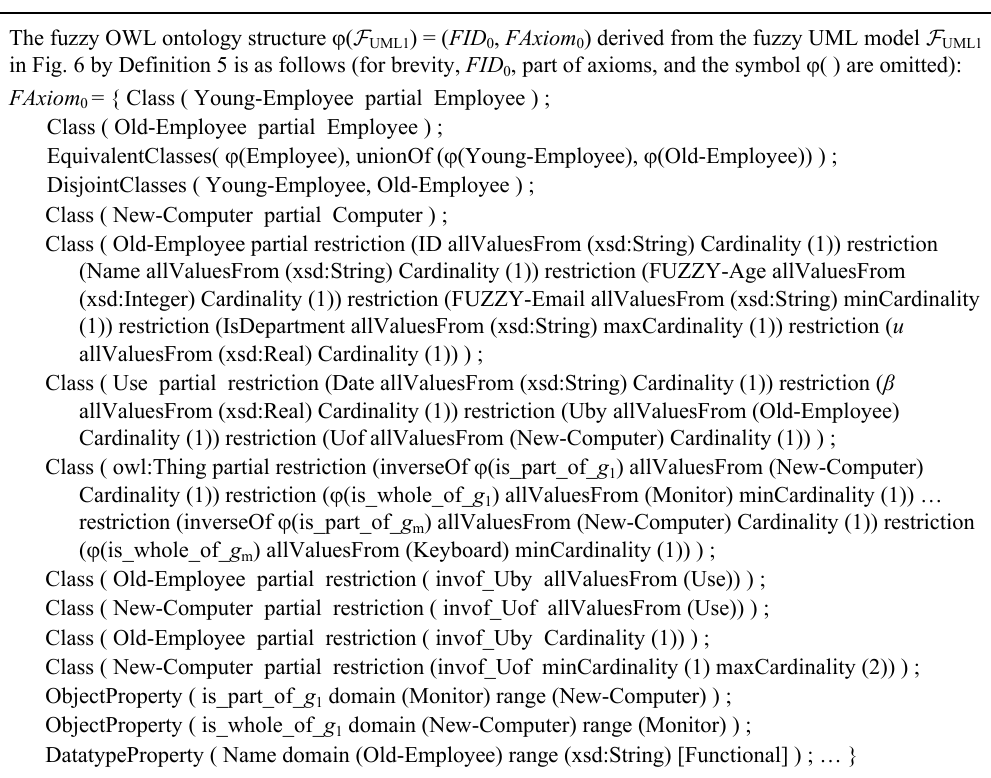
The fuzzy OWL ontology structure ϕ ( F UML1 ) = ( FID 0 , FAxiom 0 ) derived from the fuzzy UML model F